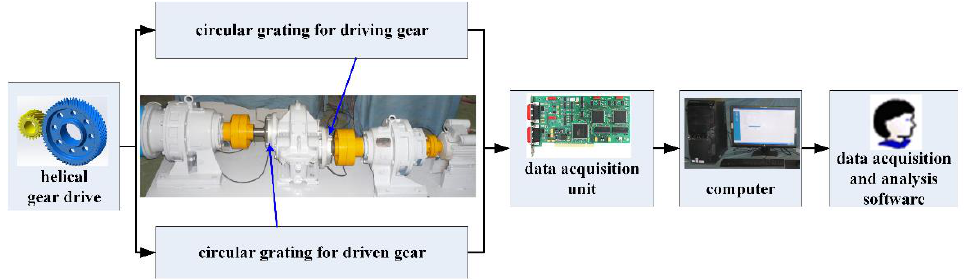
Figure 10. Experimental scheme.